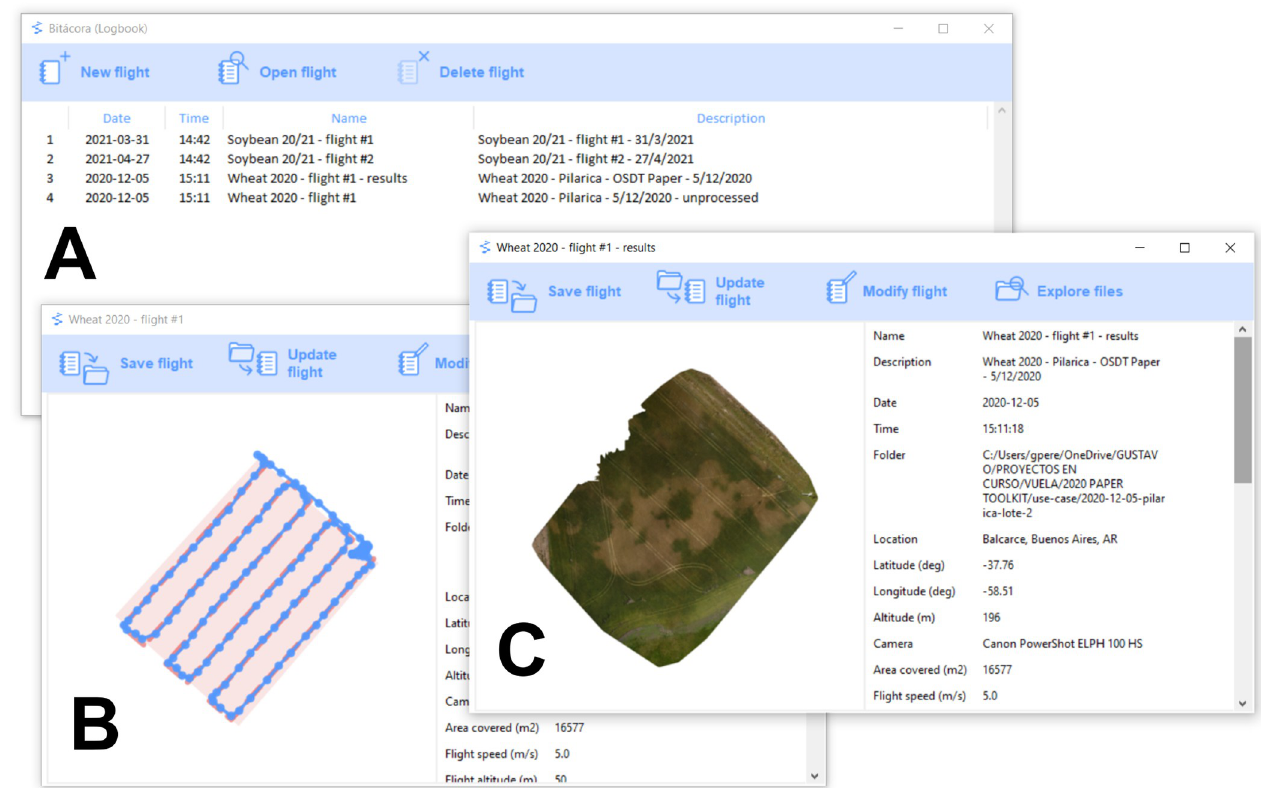
Fig 2. Screenshot from the “Bita´cora” software. (A) The main window, showing the list of logs already registered in the logbook. (B-C) Individual flight windows showing details for selected flights.